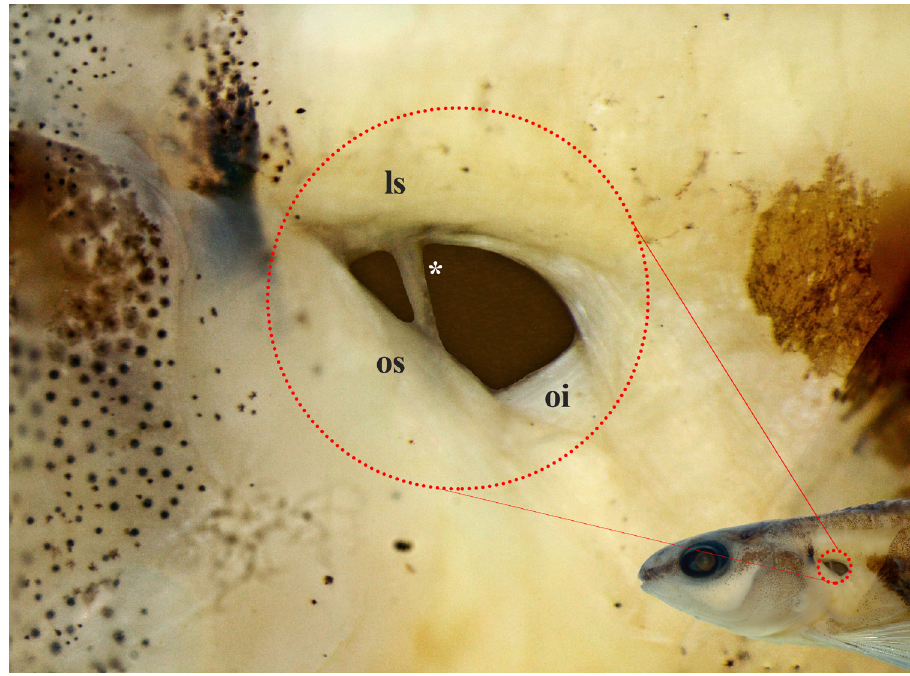
FIGURE 3 | Pseudotympanum of Characidium krenak (MZUSP 112265, 40.0 mm SL, paratype) in lateral view. Overlying skin, adipose tissue and lateral-line nerve removed. ls, lateralis superficialis ; oi, obliquus inferioris ; os, obliquus superioris . Asterisk indicates the rib of the fifth